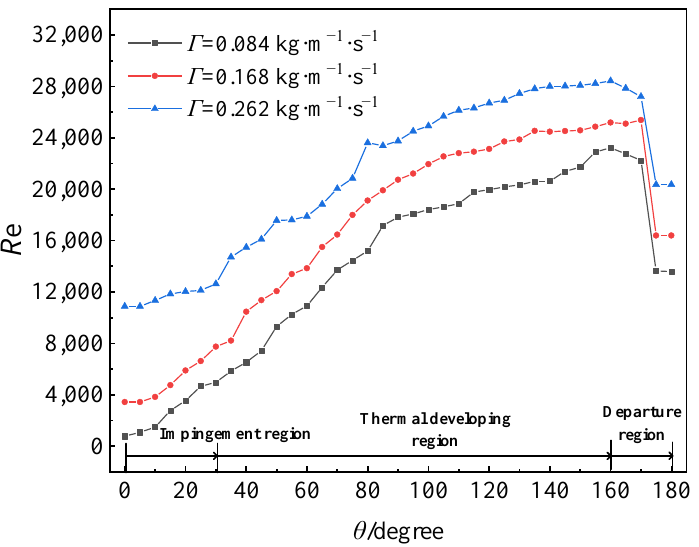
Figure 5. Local Reynolds number around tube under various spraying densities.